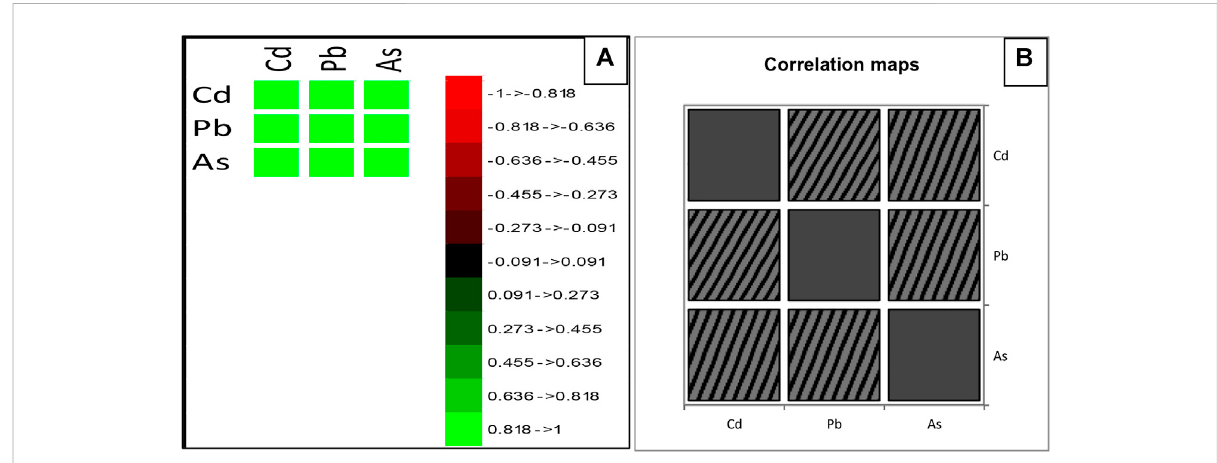
Frontiers in Environmental